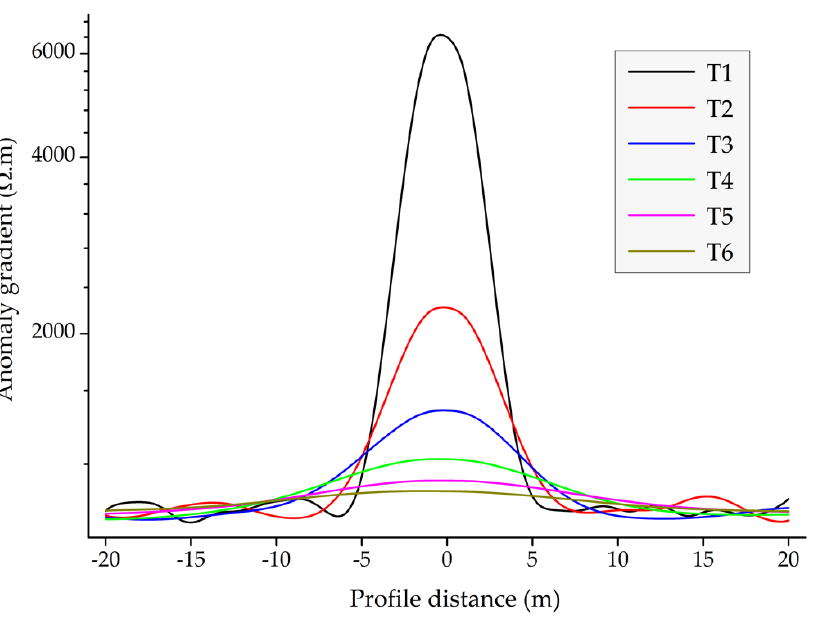
Figure 12. Resistivity anomaly gradient for the air-filled cavity set at different survey depths using the dipole-dipole (DD) array.